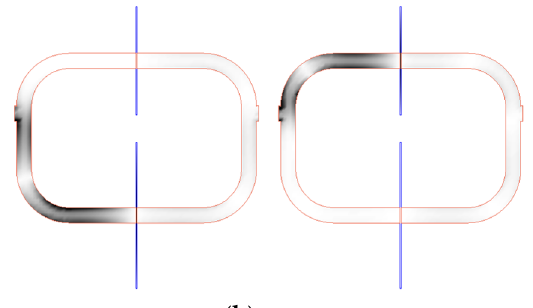
Figure 4. ( a ) Frequency response of the sensitive part of the bare reader inferred from lossless electromagnetic simulation and circuit simulation of Figure 2. The extracted element parameters are C su = 30.2 fF, C gu = 0.06 pF, C u = 0.40 pF, L u = 3.58 nH, C sl = 30.2 fF, C gl = 0.13 pF, C l = 1.26 pF, and L l = 2.02 nH. Such simulations have been inferred by means of the Keysight ADS software; ( b ) Current distribution of the sensitive part of the reader at the fundamental resonance frequency of the slot resonator of the upper and lower branch.